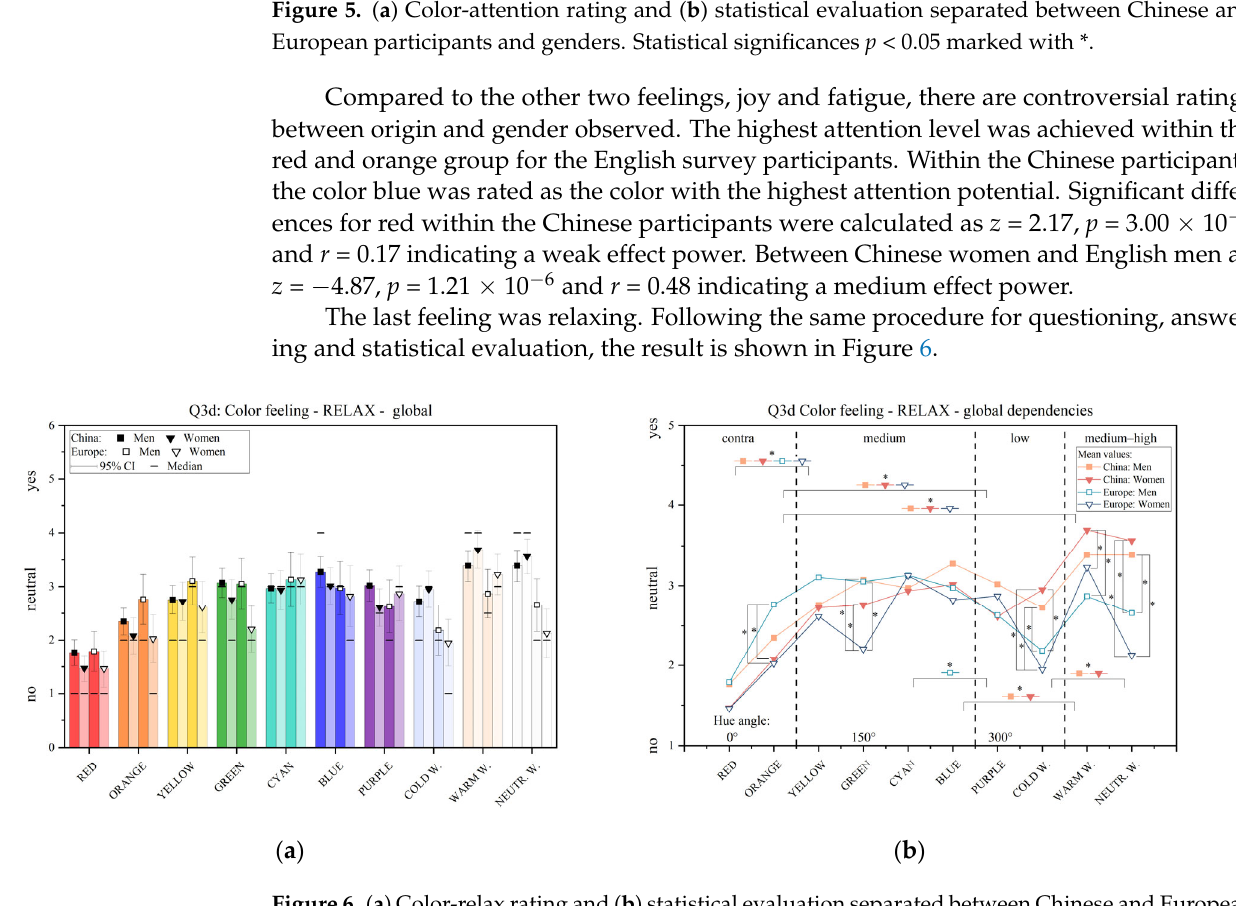
Figure 6. ( a ) Color-relax rating and ( b ) statistical evaluation separated between Chinese and European participants and genders. Statistical significances p < 0.05 marked with *.